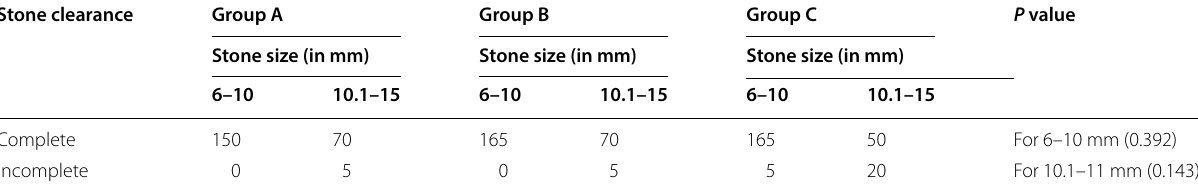
Table 5 Comparison of groups in terms of stone clearance time Groups Clearance time in days